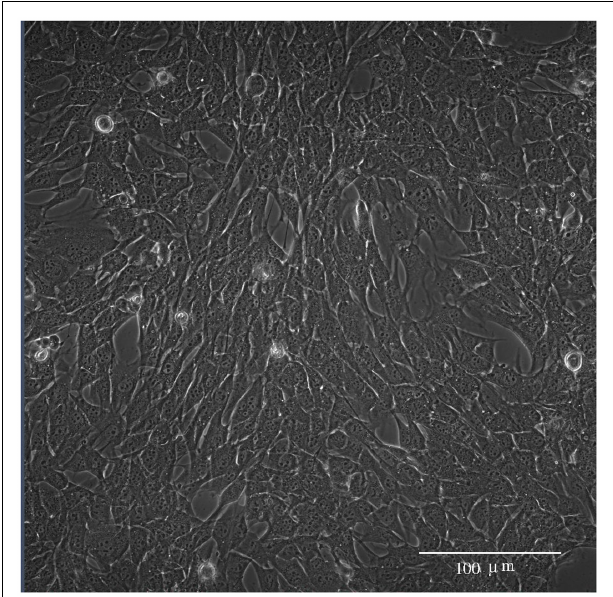
FIGURE 1 | Phase contrast image of BC3H1 cells short after YTX exposure